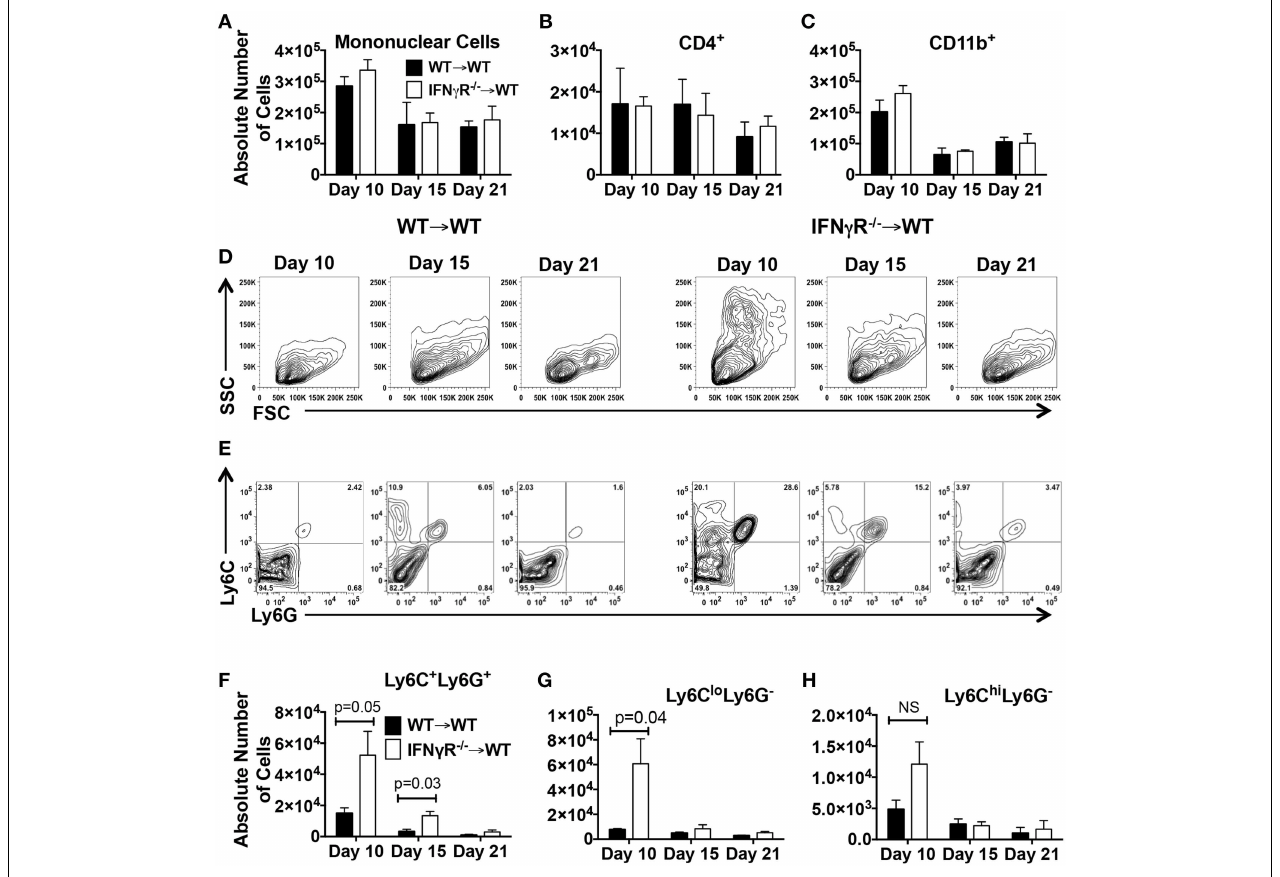
FIGURE 2 | Mice deficient in the IFNGR in the peripheral immune system do not have increased numbers of mononuclear, CD11b + or CD4 + cells in the CNS during EAE, but have significant increases in neutrophils and macrophages. BM chimera mice were generated by transplanting WT mice with donor BM from either WT (WT → WT) or IFNGR − / − (IFNGR − / − → WT) mice as described ( Ponomarev et al., 2005). On days 10, 15, and 21 after EAE induction total mononuclear cells were isolated and counted on a hemacytometer and subsequently analyzed by flow cytometry for CD45 (total